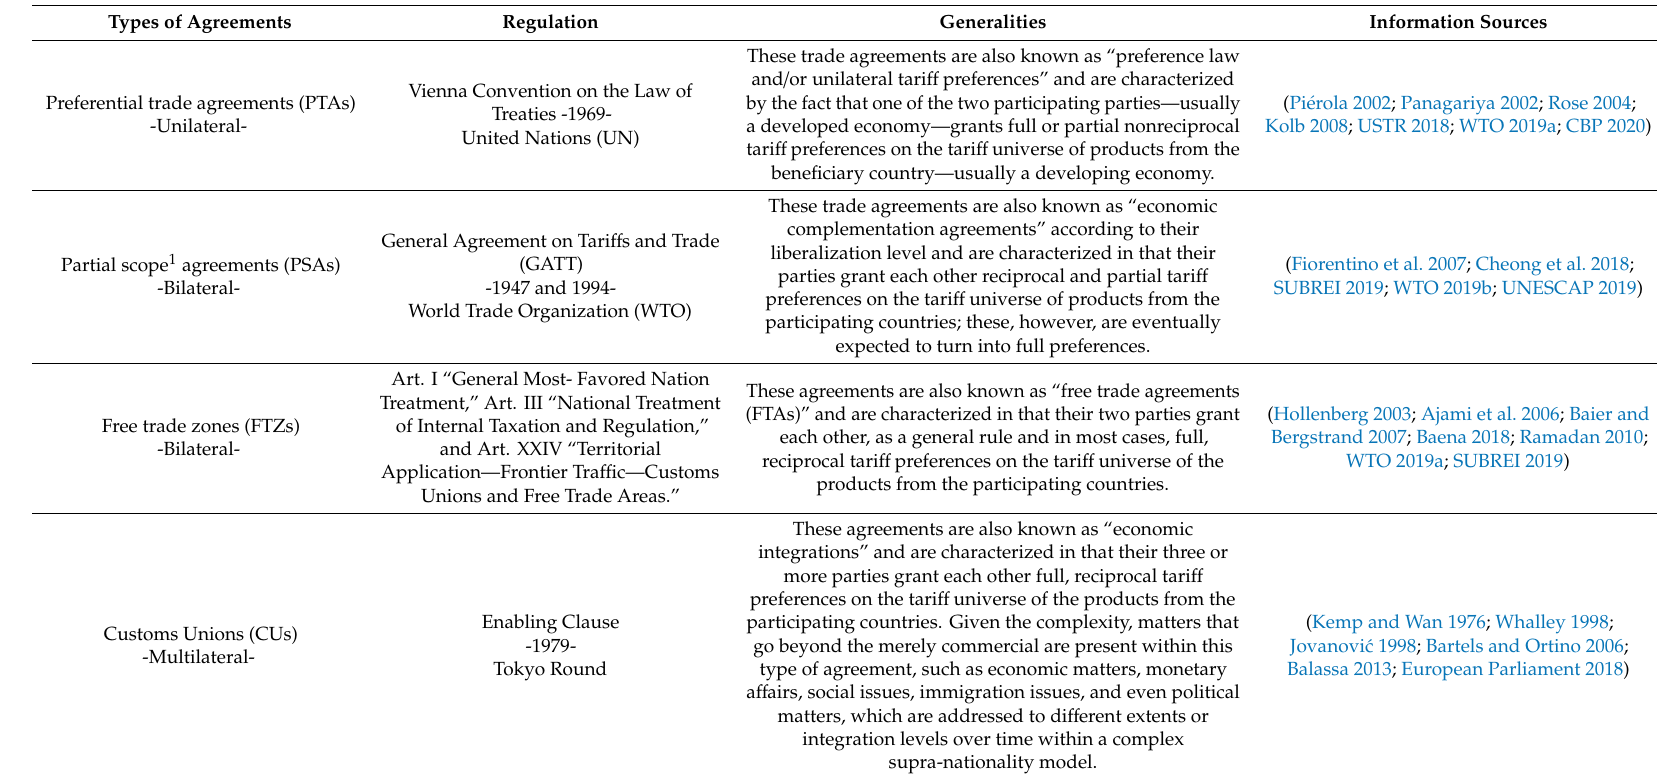
Table 1. Types of trade agreements within the multilateral trading